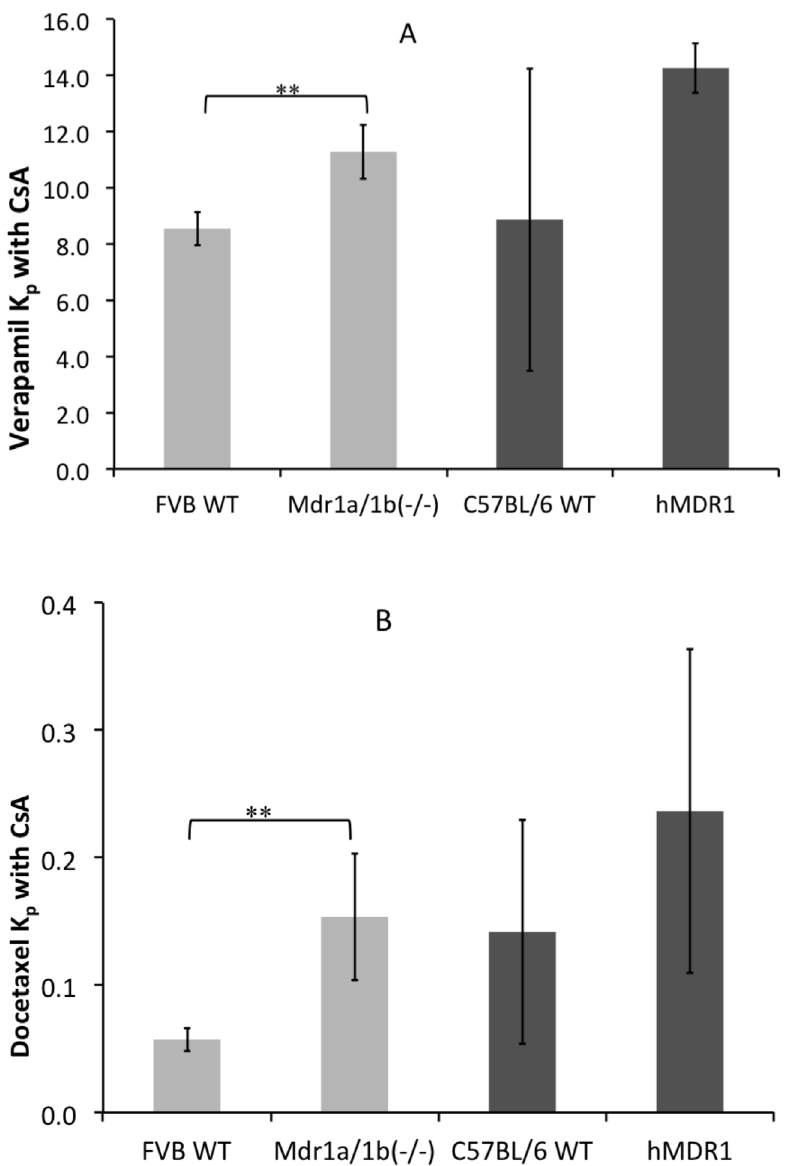
Fig 4. Comparison of K p between the Mdr1a/1b(-/-) mice with FVB WT controls and hMDR1 mice with C57BL/6 WT controls with their wild type for verapamil (A) and docetaxel (B) in the presence of